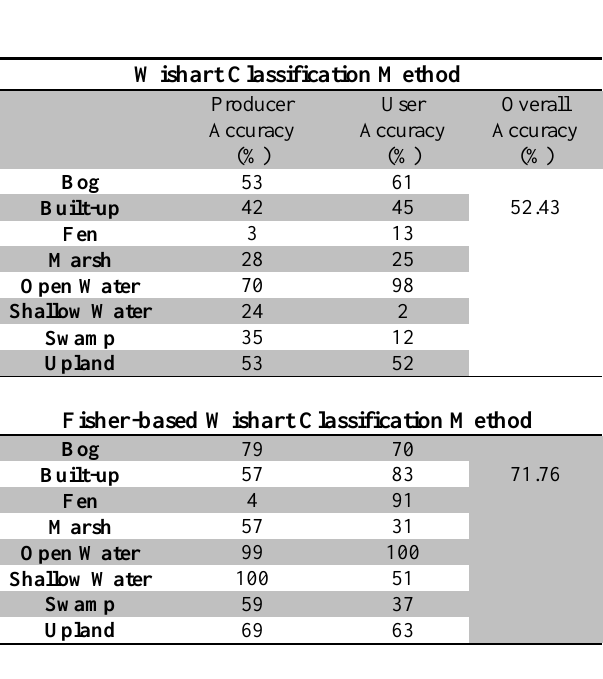
Table 1. Classification accuracy based on the coherency matrix for conventional and Fisher-based Wishart classification